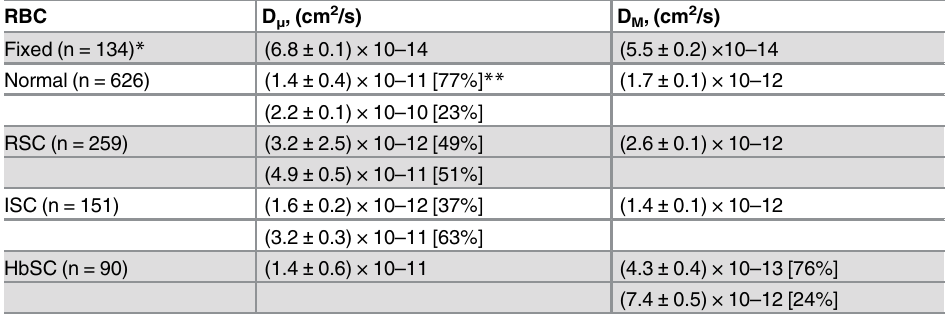
Table 1. Microscopic and macroscopic diffusion coefficient data for various healthy and sickle cell erythrocytes populations. RBC D μ , (cm 2